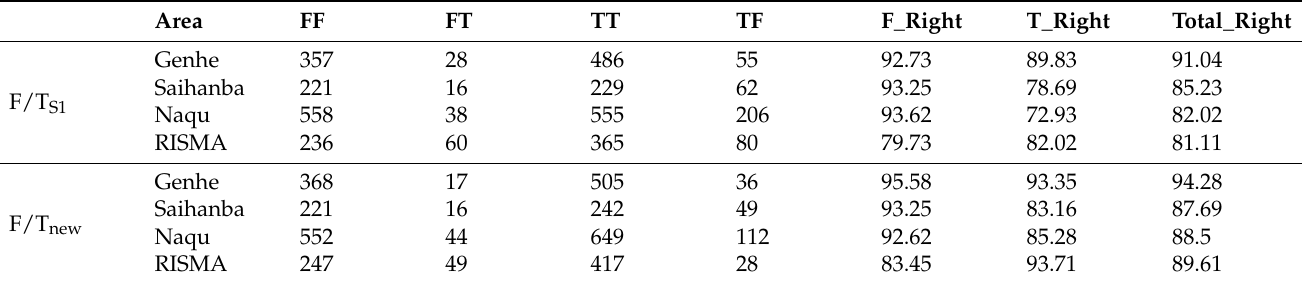
Figure 21. Comparison of thawed ( a ), frozen ( b ), and total ( c ) accuracies between F/T S1 and F/T new at a 1 km resolution. Table 7. Classification accuracy (%) statistics for F/T S1 and F/T new .